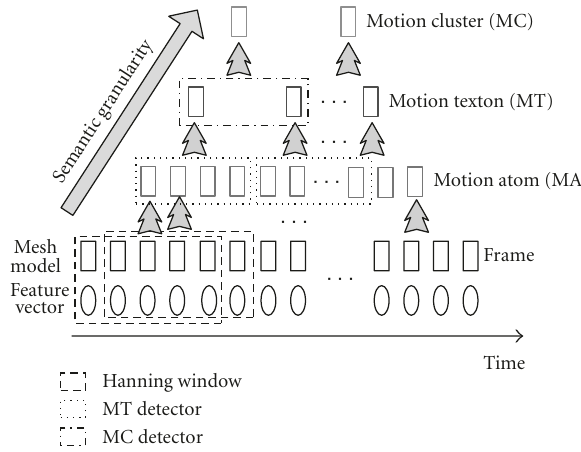
Figure 2: Hierarchical motion structure in TVM.